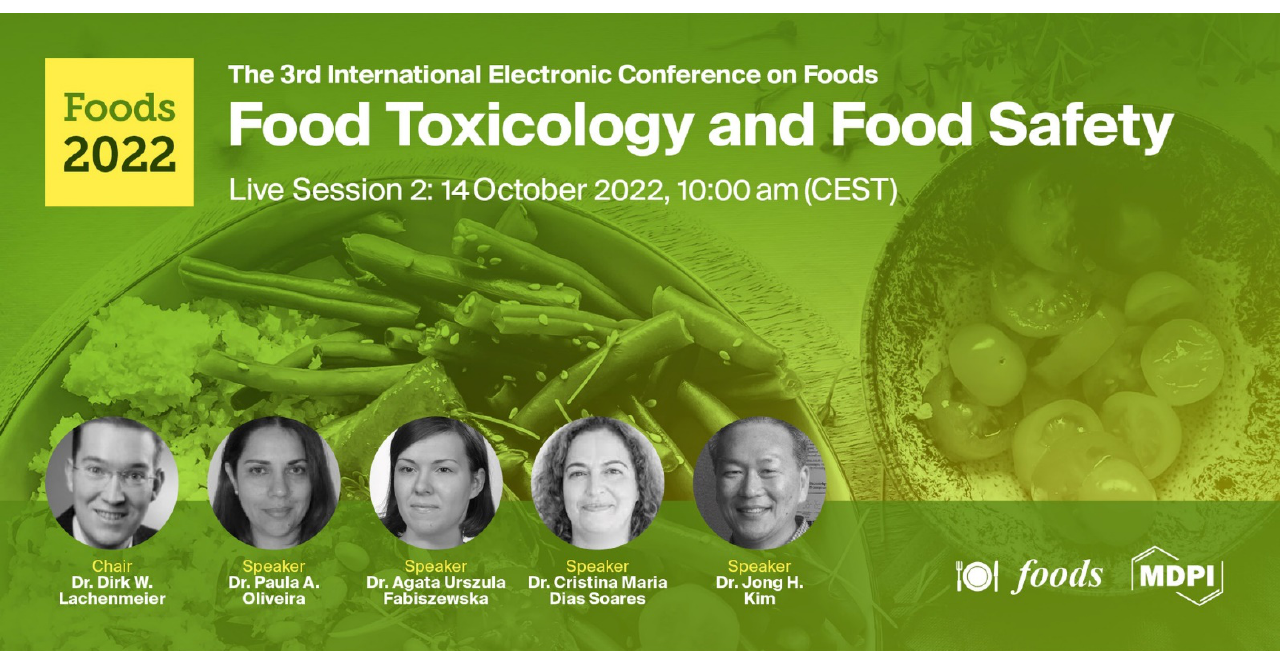
Figure 2. Speakers of the Foods 2022 Conference live session 2 on food toxicology and food safety.